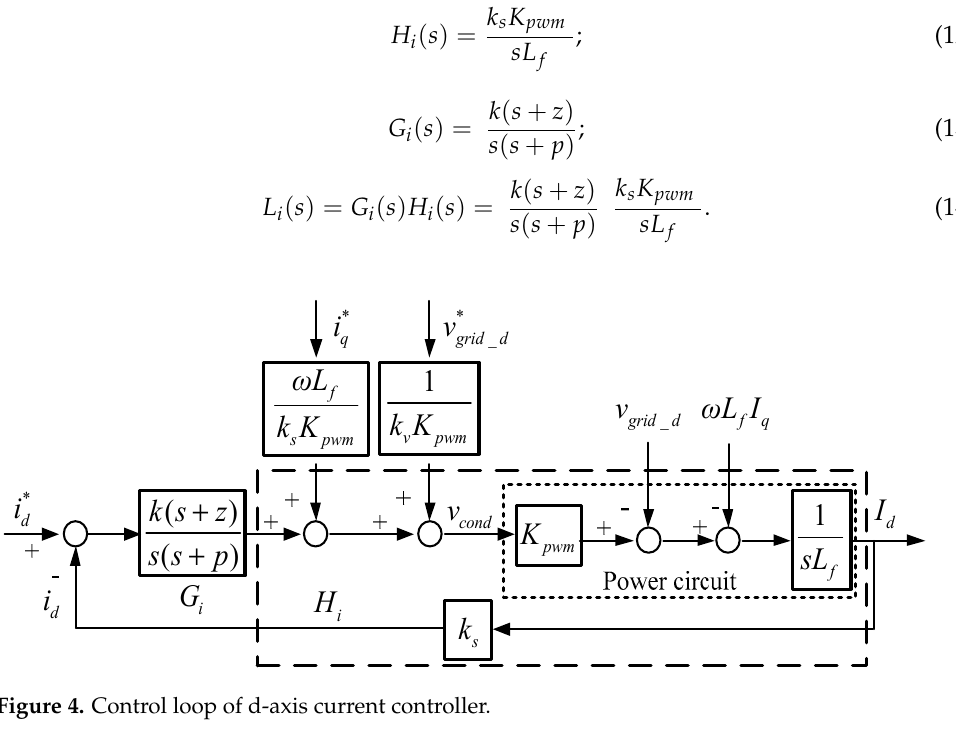
Figure 4. Control loop of d-axis current controller.